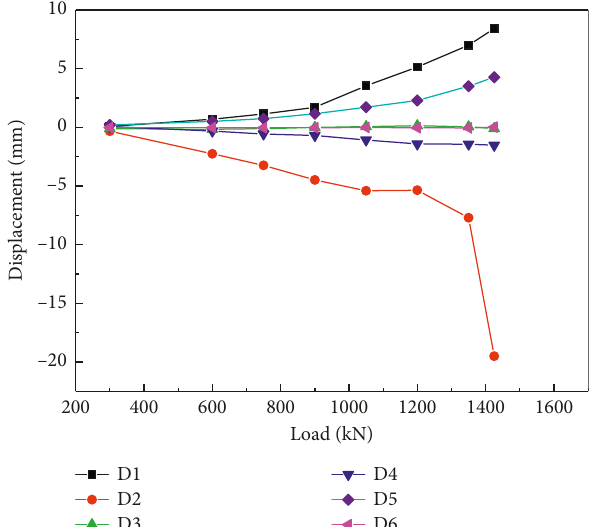
Figure 21: Load-displacement curves in Model 3.